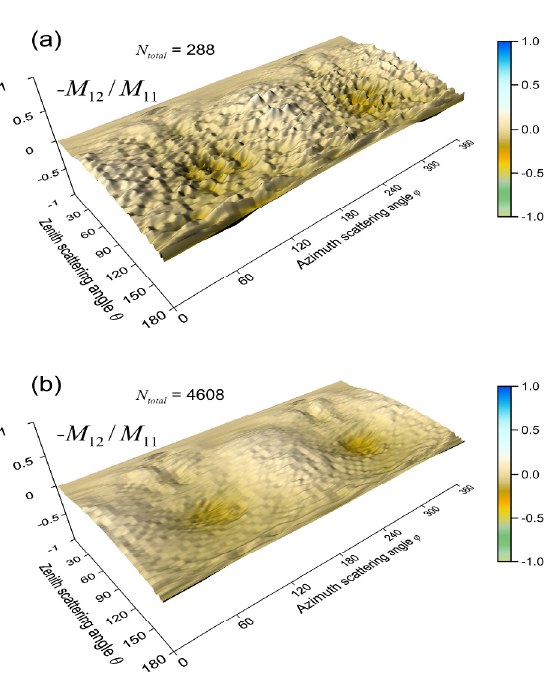
Figure 4. The same as in Fig. 3 for the element M 12 In the forward scattering direction, the diffracted field that is weakly changing with particle orientations becomes predominant. Similarly, the light beams scattered near the forward direction undergo a little number of reflections inside the faceted particles. Therefore the scattering to the hemisphere is less sensitive to the orientation